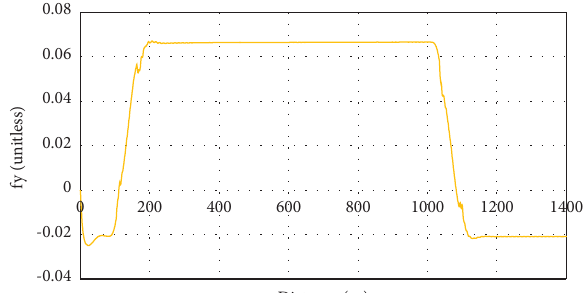
Figure 13: Side friction factor in spiral horizontal curves along the path of a truck.